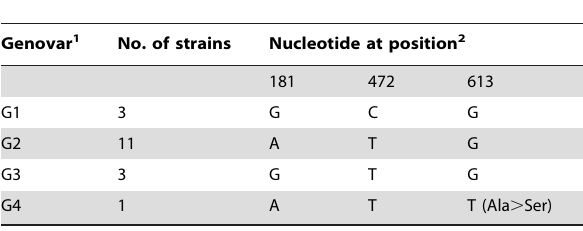
Table 7. Variable nucleotide positions and genovar definition based on the sequences of the glp Q gene of 18 human and tick-borne isolates of B. persica in Israel and the West